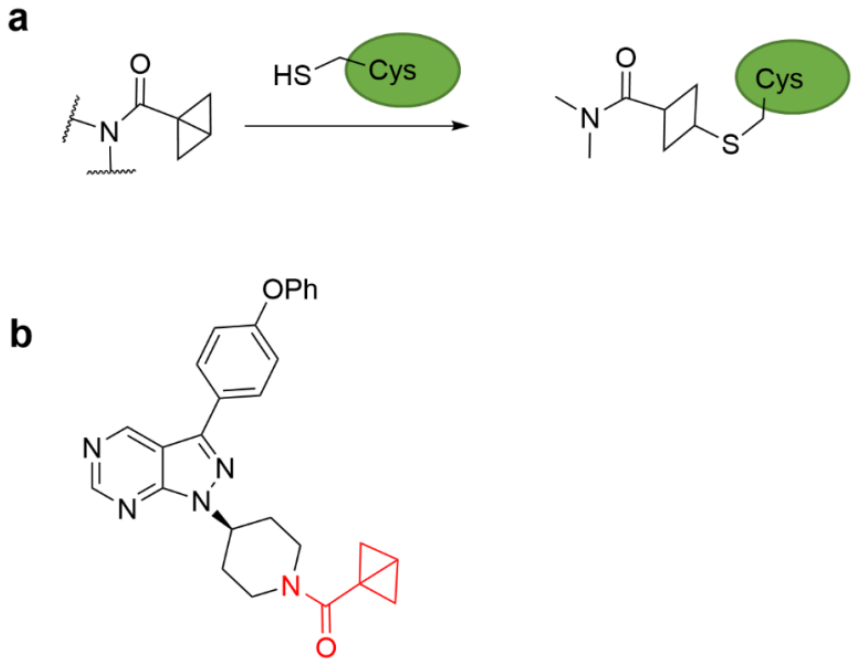
Figure 8. ( a ) Chemical structure of the BCB amide. ( b ) Chemical structure of the BCB amide-based irreversible covalent BTK inhibitor.